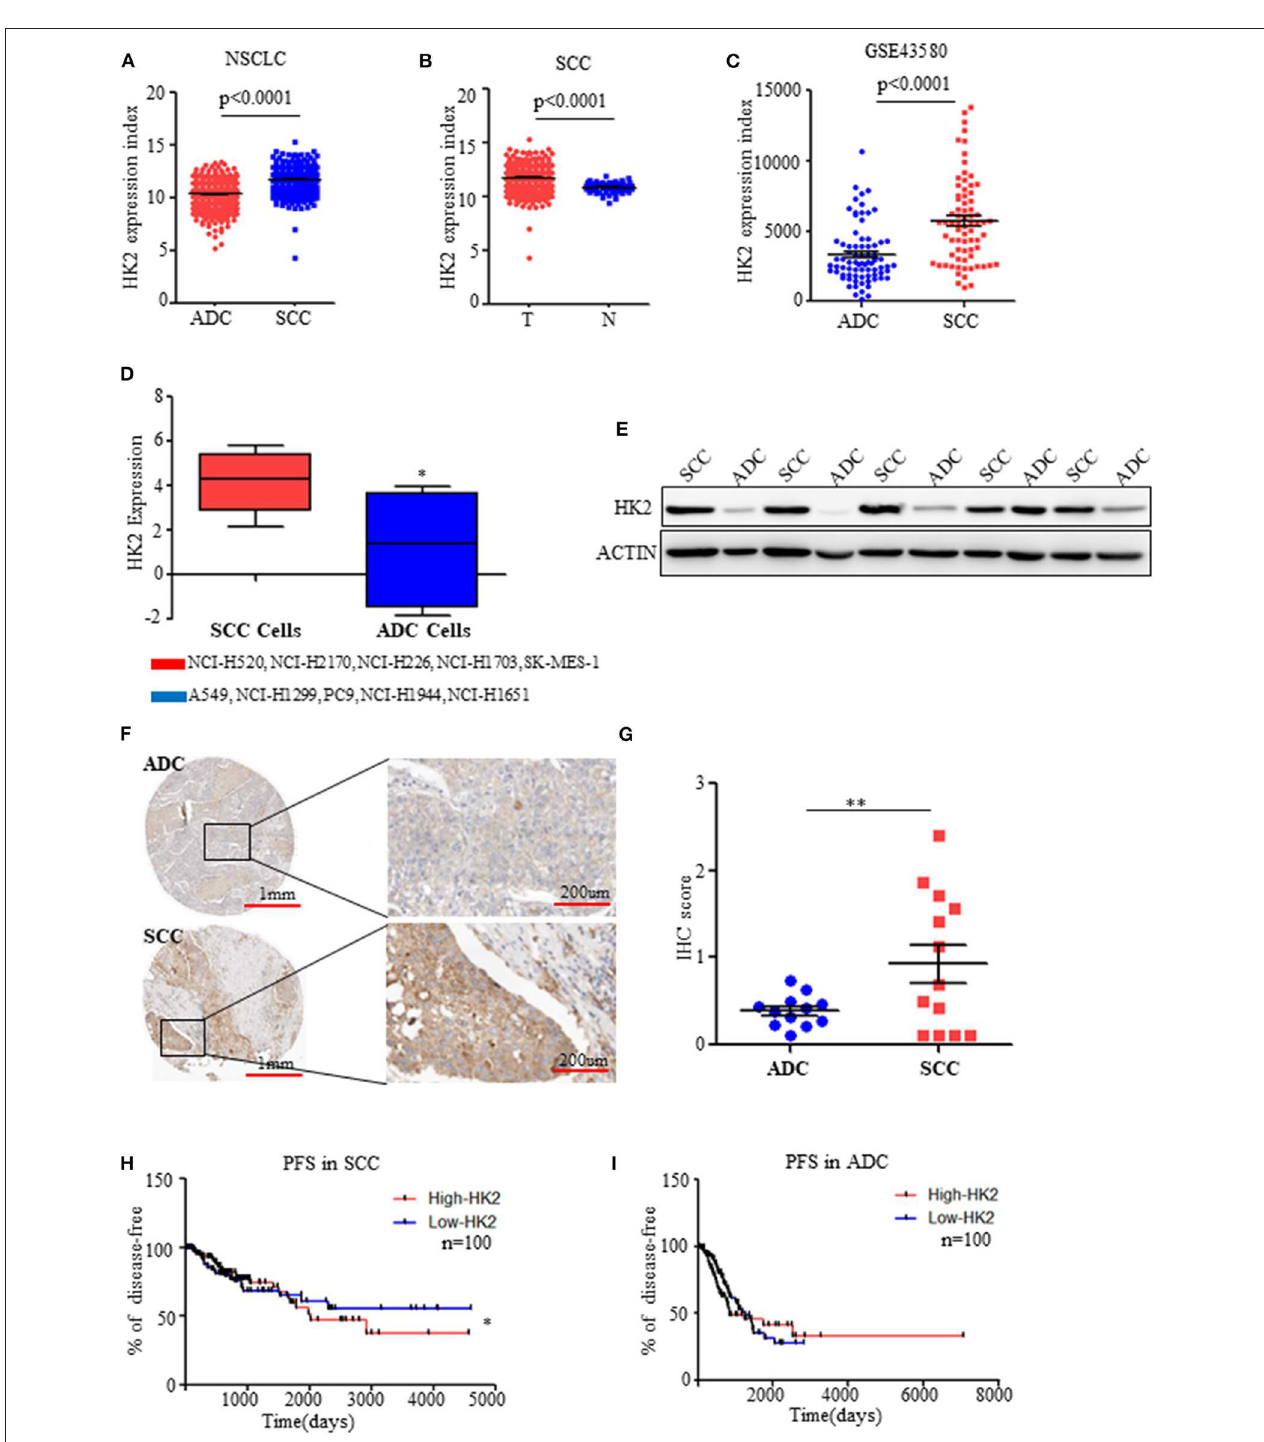
FIGURE 1 | HK2 is highly expressed in SCC compared to ADC. (A) HK2 expression index in NSCLC samples from TCGA database. (B) HK2 expression index in SCC tumor samples compared with that in normal tissues from TCGA database. (C) HK2 expression index in NSCLC from the GSE43580 cohort. (D) HK2 expression in SCC cell lines (NCI-H520, NCI-H2170, NCI-H226, NCI-H1703, SK-MES-1) and ADC cell lines (A549, NCI-H1299, PC9, NCI-H1944, NCI-H1651). (E) Western blot showing the expression of HK2 in lung SCC ( n = 6) and ADC ( n = 6) samples. (F) Representative image of immunohistochemical (IHC) staining for HK2 expression in SCC ( n = 12) and ADC ( n = 11) patients. (G) IHC scores to quantify the expression of HK2 in ADC and SCC samples. (H) Percentage of PFS in SCC patients according to HK2 expression (High-HK2 n = 100, Low-HK2 n = 100) in TCGA database. (I) Percentage of PFS in ADC patients according to HK2 expression (High-HK2 n = 100, Low-HK2 n = 100) in TCGA database. * p < 0.05, ** p < 0.01.